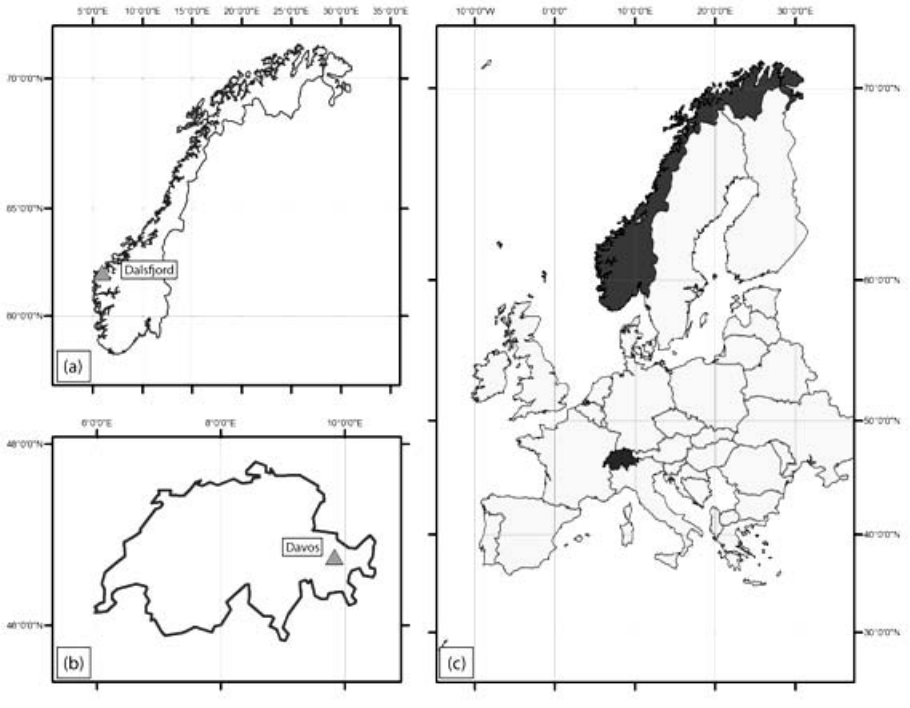
Fig. 2. Data collection sites depicted by grey triangles in (a) Norway and (b) Switzerland.